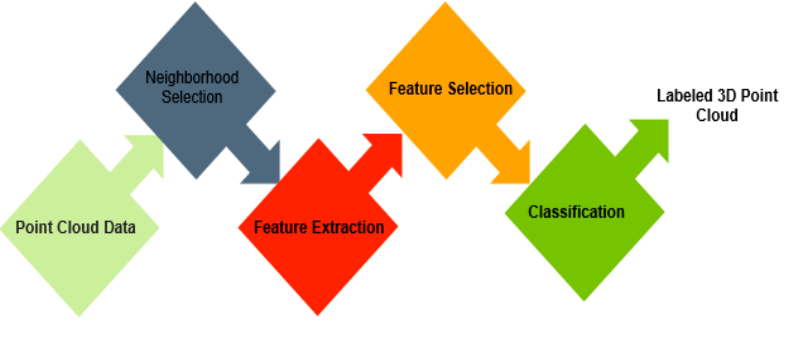
Figure 4. SS Process flow.